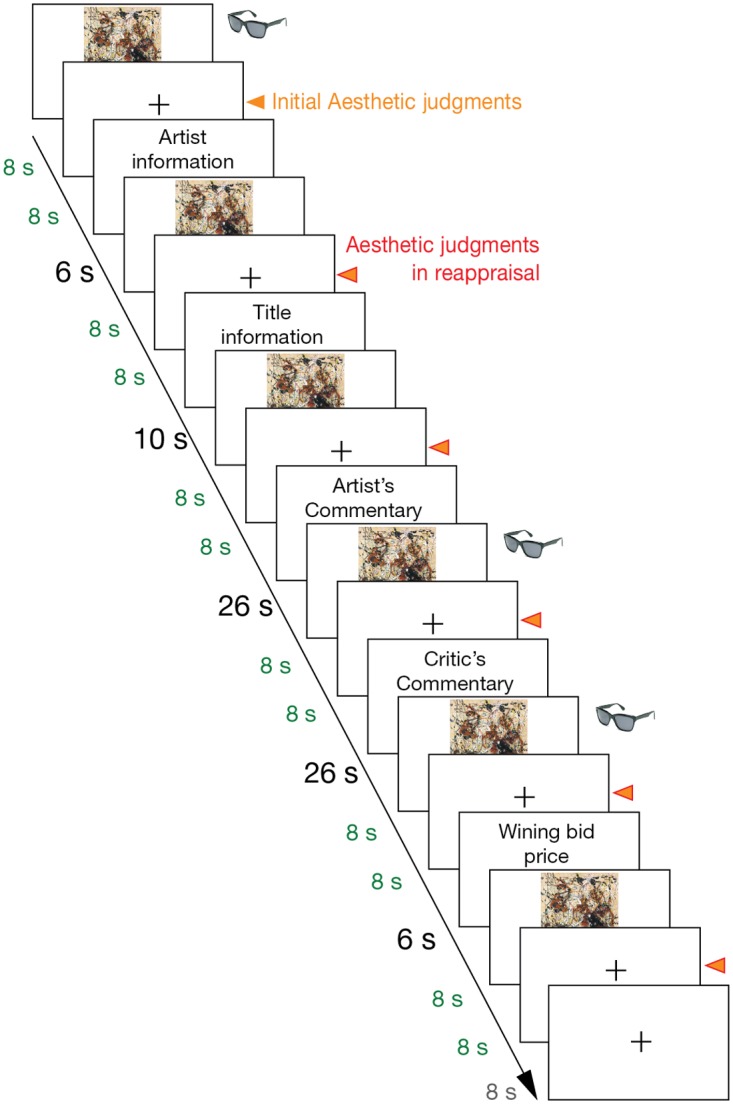
The timeline of a block of viewing experiences that includes the initial viewing and the five subsequent information-based reappraisals of a painting (No. 12 by Jackson Pollock in the figure).The painting was presented for 8 seconds (Green colored). A fixation cross was presented as the inter-stimulus interval between painting presentations. In the behavioral experiments, the subjects made their aesthetic judgments during the fixation at the indicated times, marked as triangles. The information was presented in the following order for a given duration: the artist information (6 seconds), the title information (10 seconds), the artist’s commentary (26 seconds), the critic’s commentary (26 seconds), and the most recent winning bid (6 seconds). The viewing of the next painting was begun after the inter-block interval (8 seconds). The perceptual patterns were acquired using an eye-tracker and were compared between modulations during the initial viewing and during the reappraisals after two types of commentaries (glasses symbol).